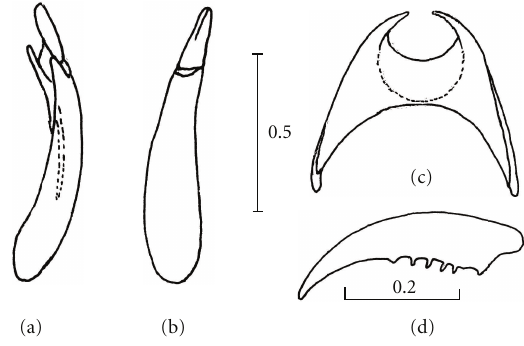
Figure 2: Outlines. (a) Scaphinion clavatus aedeagus, lateral; (b) ditto, dorsal; (c) S. clavatus sternite 8; (d) Litopous baehri , tarsal claw.